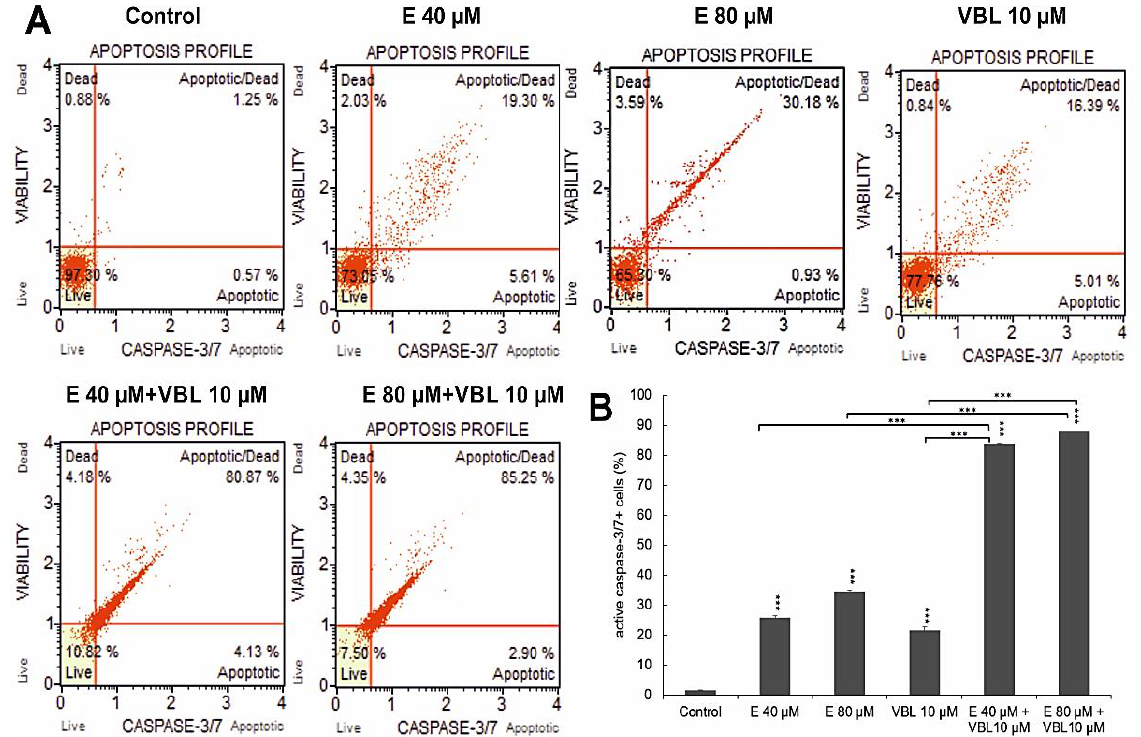
Figure 2 . Changes in the caspase 3/7 activity induced by emodin and vinblastine. ( A ) Live cells (caspase 3/7-/7-AAD-), cells in early (caspase 3/7+/7-AAD-) and late apoptosis (caspase 3/7+/7-AAD+), dead cells (caspase 3/7-/7-AAD+). ( B ) Percentage of cells with active caspase 3/7. Differences statistically confirmed at: *** p < 0.001.